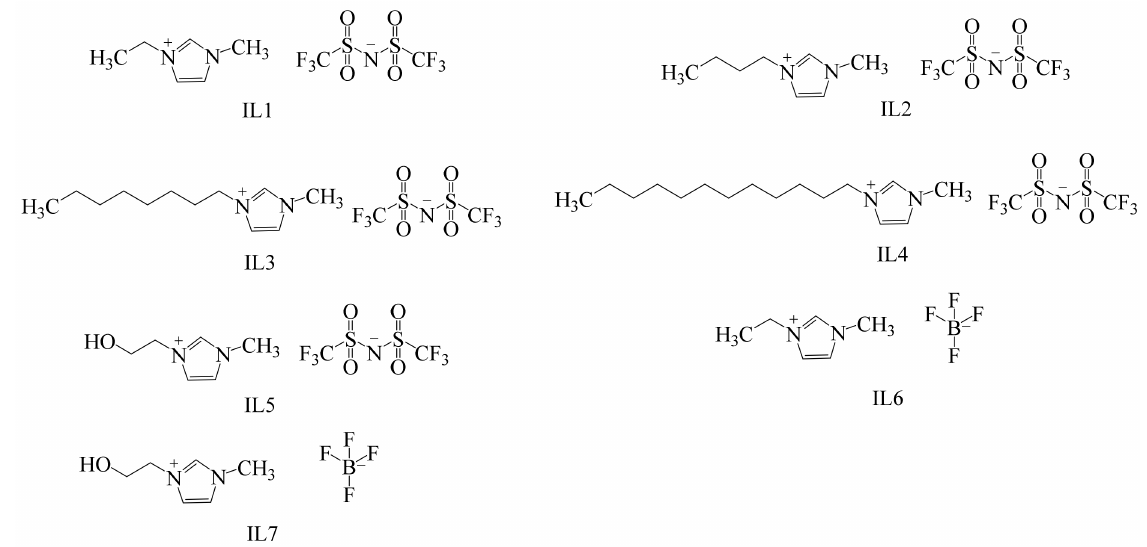
Figure 7. ILs employed in ILAG